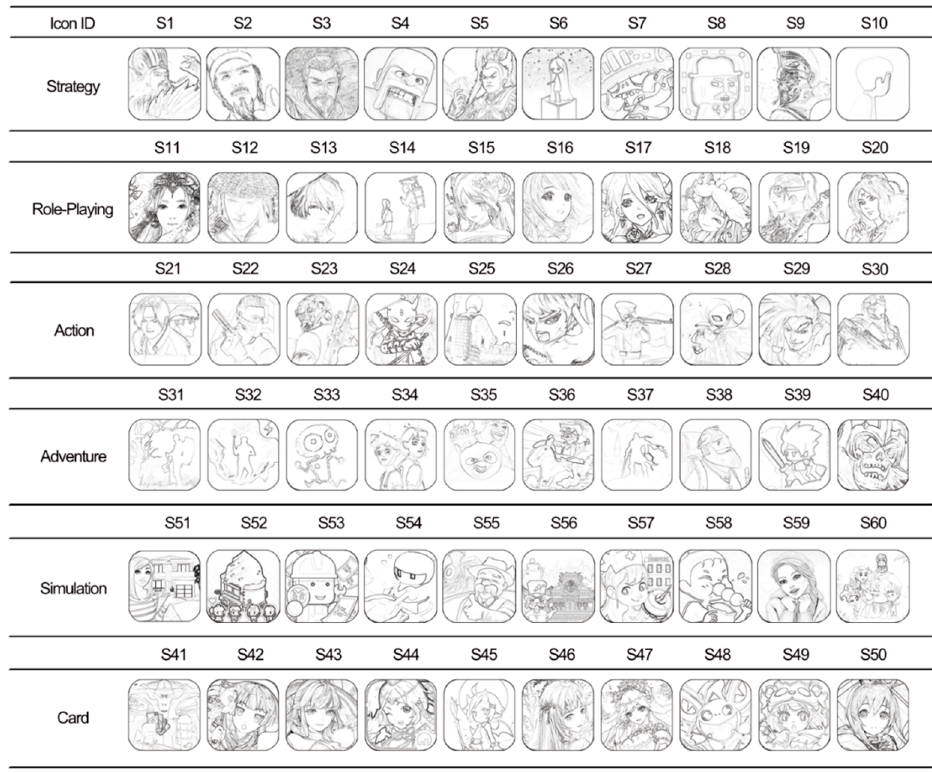
Figure 2. Game icons with high visual matching in 6 categories.